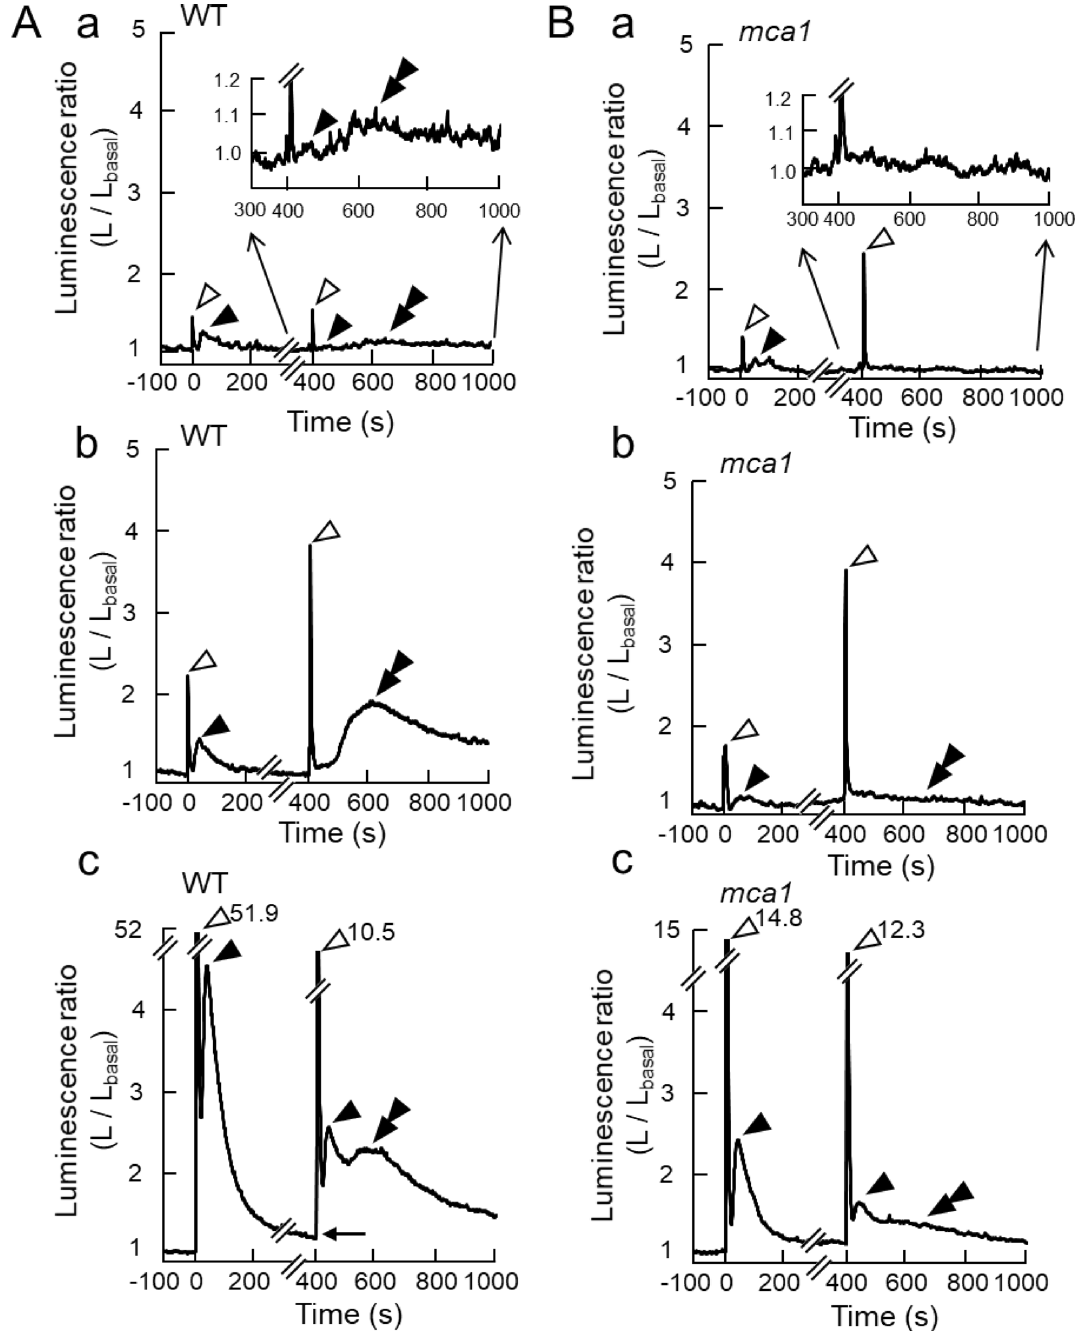
Figure 2. [Ca 2+ ] c -increases induced by forward rotation to upside down and backward rotation to the upright position under 1, 3, and 5 g conditions. ( A ) a typical [Ca 2+ ] c -increase in wild-type seedlings induced by forward rotation and backward rotation under 1 (panel a ), 3 (panel b ), and 5 g (panel c ) conditions. ( B ) A typical [Ca 2+ ] c -increase in an mca1 -knockout mutant induced by rotations under 1, 3, and 5 g conditions. The very slow [Ca 2+ ] c -increase is magnified and shown in the inset. Seedlings were rotated at 0 s and at 400 s. The notation is the same in panels A and B, and those of the arrowheads are the same as Fig. 1. Note the presence of the tail of the slow [Ca 2+ ] c -increase at 400 s in panel Ac (horizontal